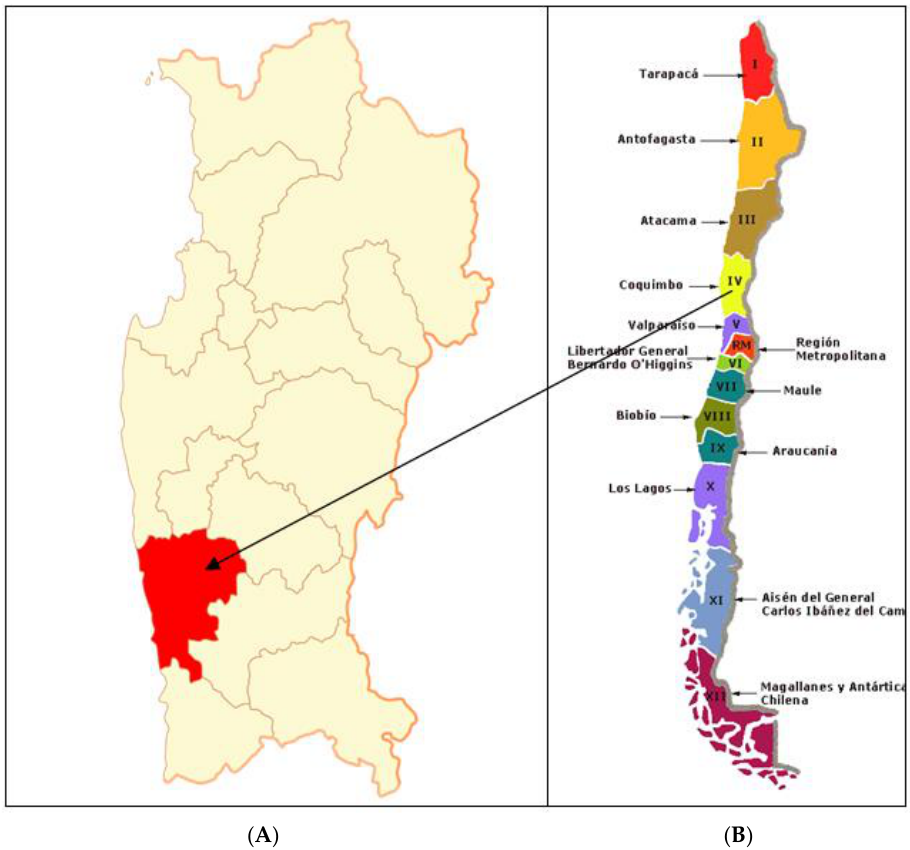
Figure 1. The IV Region of Coquimbo ( A ) with the Canela commune (in red). The Huentelauquén Agricultural Community (HAC) is in the southern coastal border of the Canela Commune (see also Figure 2). The map of Chile ( B ).